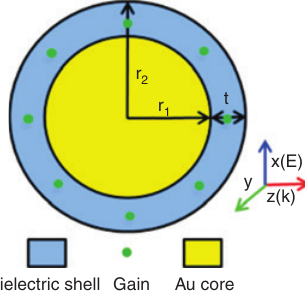
Figure 1: Geometry of a core-shell nanoparticle and associated coordinate system.